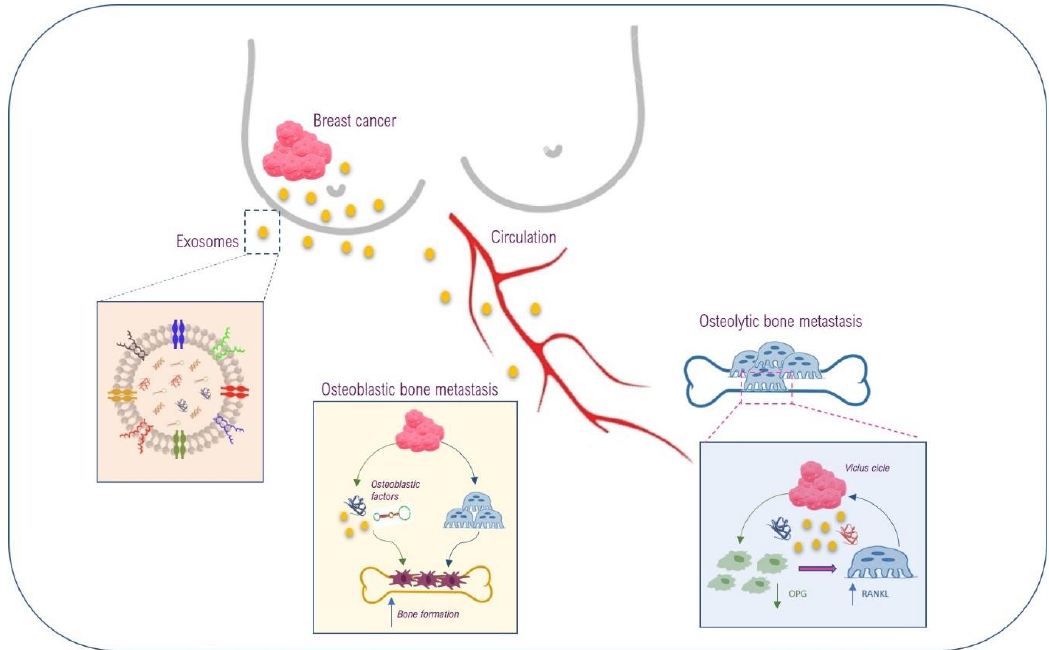
Figure 4. Schematic representation of EVs involvement in the communication between breast cancer cells and bone/bone marrow niche. BC cells of primary tumor release both soluble factors and EVs containing lipids, proteins, DNA, mRNAs and microRNAs (schematically represented in the insert on the left); CTCs also move from primary tumors towards bone. Both EVs and CTCs arrive to bone tissue through circulation. Soluble and EVs-associated factors can modulate bone microenvironment supporting BC cells in osteoblastic or osteolytic bone metastasis induction.